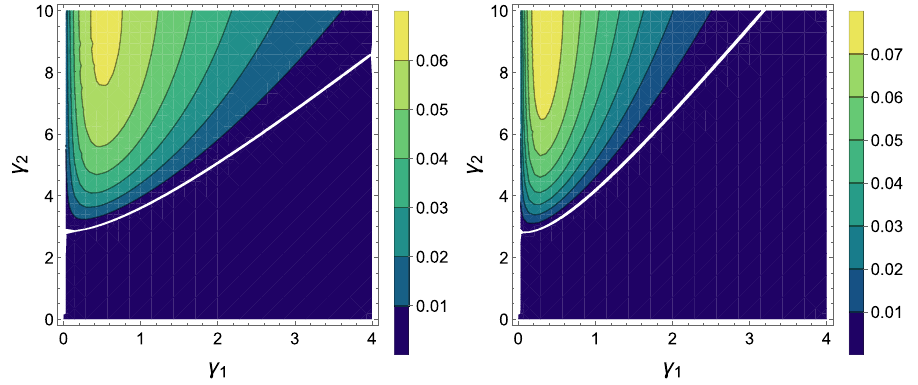
Figure 3. Contour plots of the concurrence of state ρ in Eq. (4) corresponding to ¯ n b = 0 and ¯ n a = 1 (left) and ¯ n = 2 (right) as a function of γ 1 and γ 2 , with J = 1 and D = 1 for both a